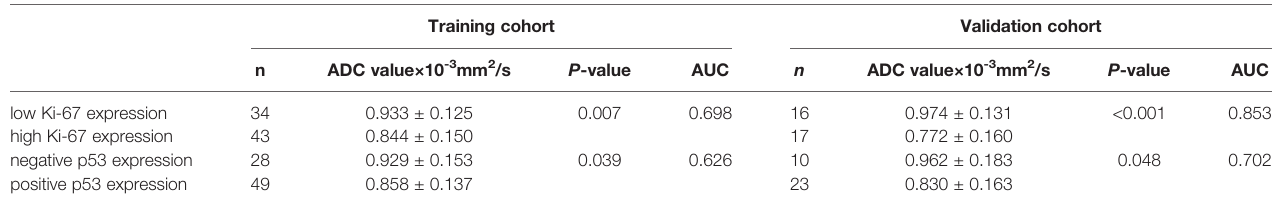
TABLE 2 | The ADC value in relation to Ki-67 and p53 and its predictive performance.